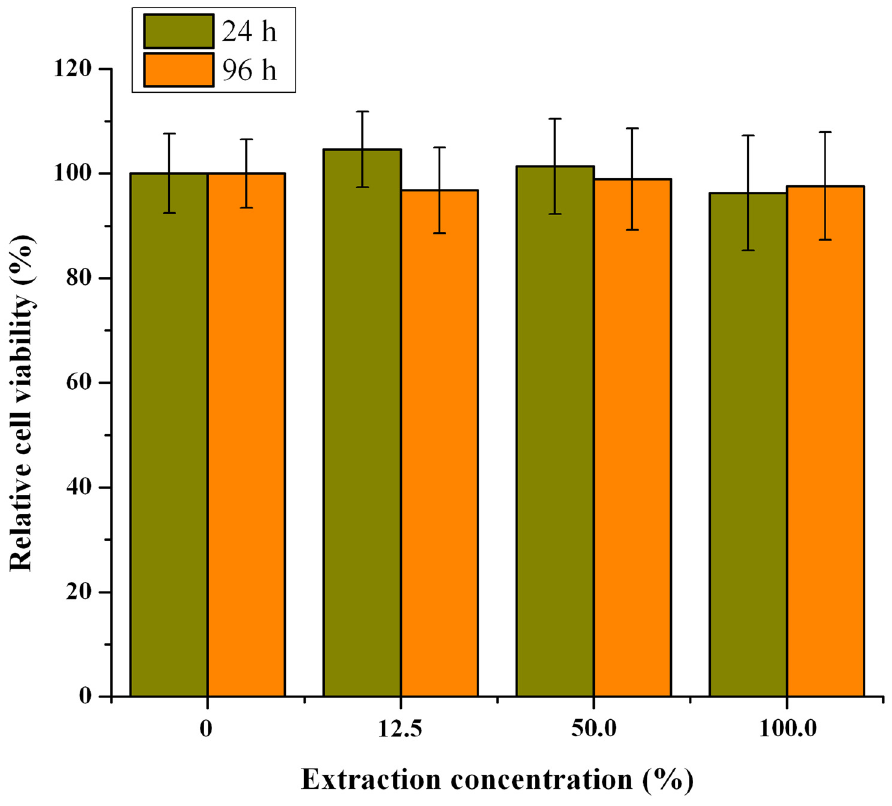
Fig 5. The MTT results for the biocompatibility of PLGA microspheres at different extraction concentrations (n = 6).